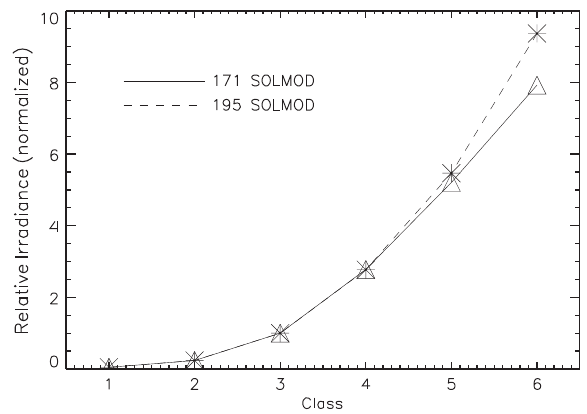
Fig. 2. Synthetic contrast calculated from the irradiance spectra for the EIT 171 Å (solid line with triangles) and 195 Å (dashed line with stars)